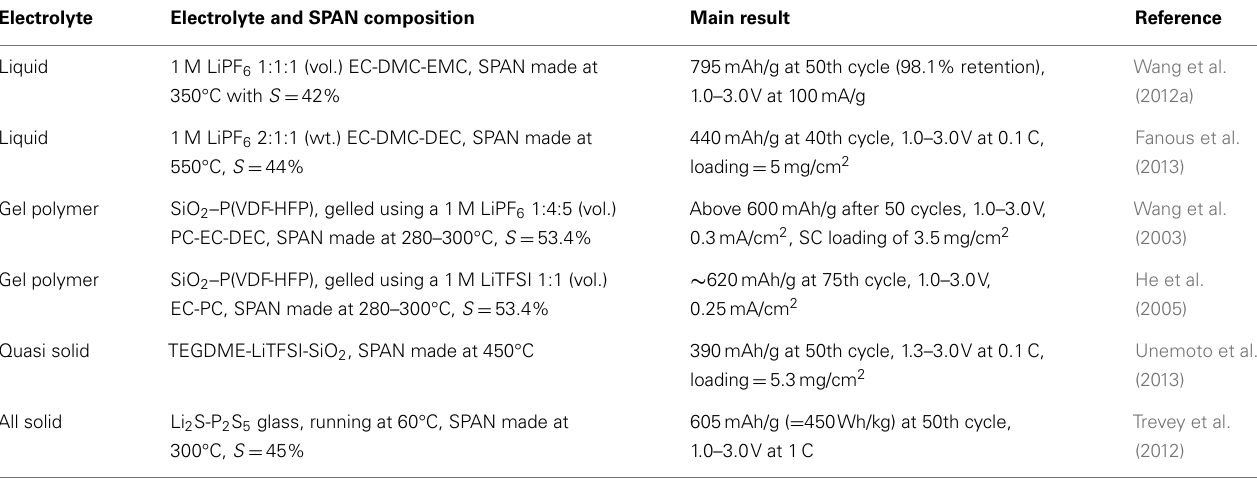
Table 2 | Cycling performance of Li/SPAN batteries with different type of electrolyte. Electrolyte